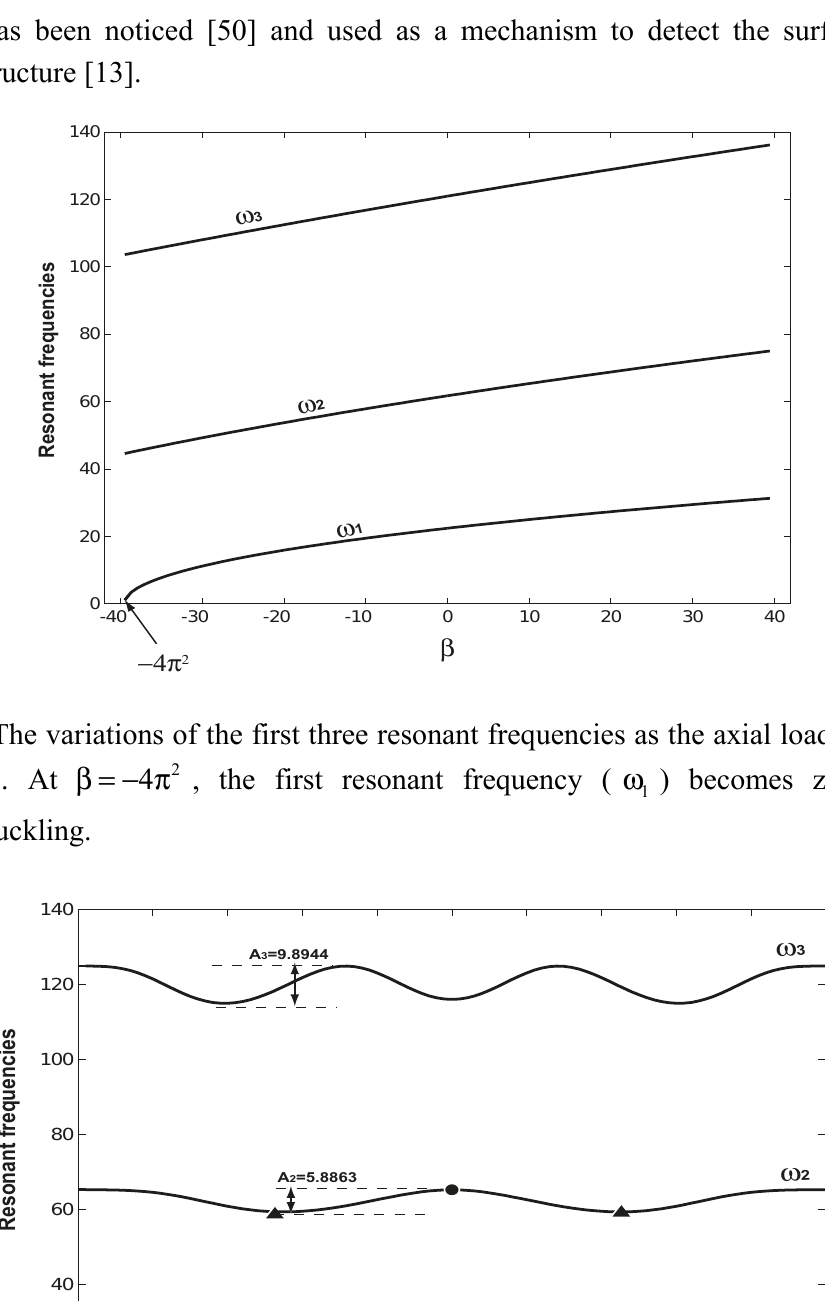
Figure 3. The variations of the first three resonant frequencies as an adsorbate moves from one clamped end to the other. Here, the mass and axial load are fixed as 0.1 α = and 10 β = . difference between the maximum and minimum of those